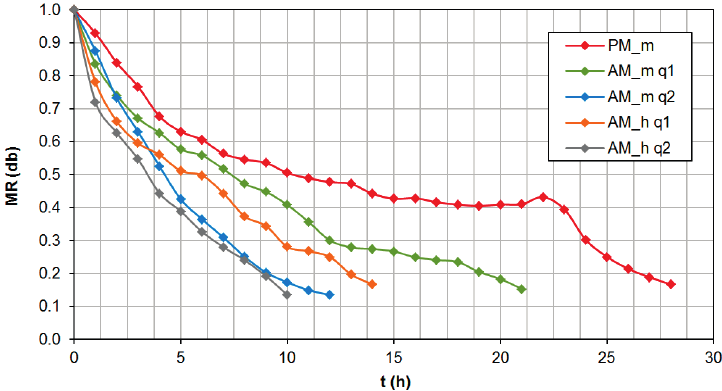
Figure 7. Influence of air mass flow on sludge residue (SLG) drying.